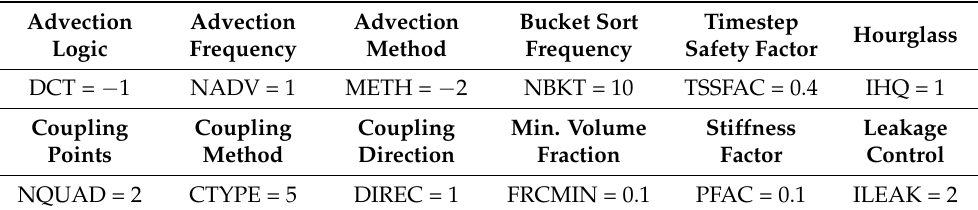
Parameters of the MMALE and fluid–structure interaction keywords used in the simulations